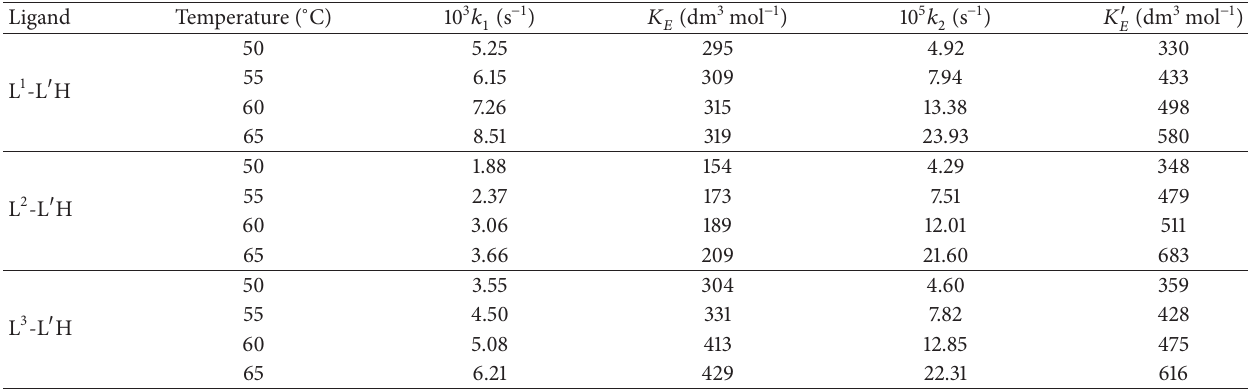
Table 3: The 𝑘 1 ,𝑘 2 , 𝐾 𝐸 , and 𝐾 󸀠 𝐸 values for different dipeptide concentration at different temperatures; [Complex A ] = 2.5 × 10 − 4 moldm − 3 , pH = 4.3, ionic strength = 0.1moldm − 3 NaClO 4